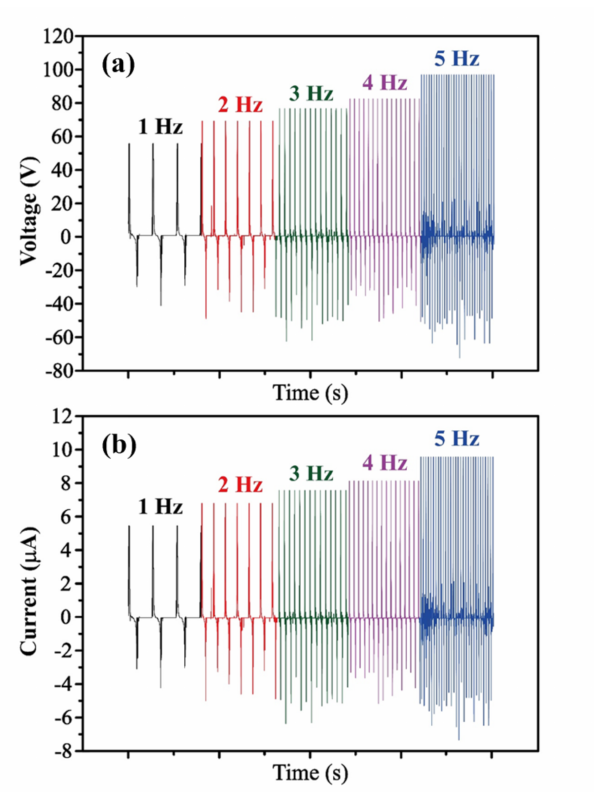
Figure 7. Output performance of TEG connected to an external load of 10 M Ω with 1 cm line pattern for impact frequencies ranging from 1 to 5 Hz: ( a ) output voltage and ( b )